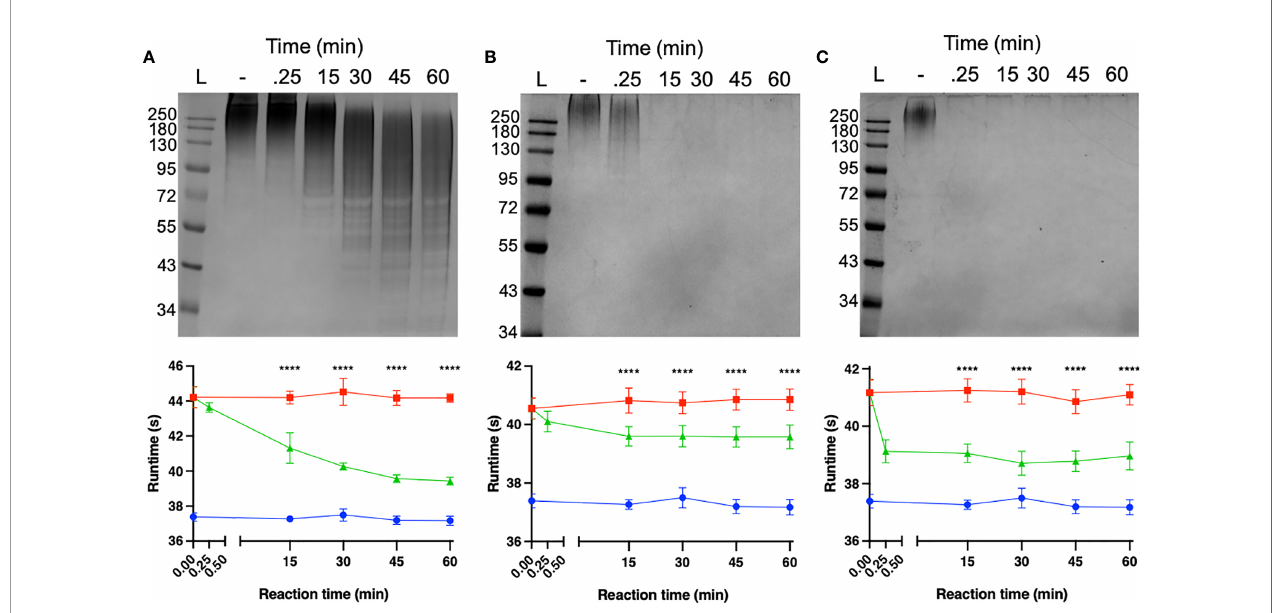
FIGURE 4 | Degradation of high-molecular-weight capsular polysaccharide from K . pneumoniae SR65 (A) , SR3 (B) and TU16 (C) following incubation at 37°C with the corresponding K1, K2 and K51 depolymerases. 10% SDS-PAGE gels; 5 m l Color Prestained Protein Standard, Broad Range (10-250 kDa) (New England Biolabs UK) as ladder; 22.5 m l loaded into each lane. Enzyme-mediated reductions in polymer viscosity as determined by Anton-Paar rolling ball viscometry are also shown alongside the corresponding gels. No polymer degradation was observed in the absence of enzyme. **** P = < 0.0001 (unpaired t-test with Welch ’ s correction between treated and untreated